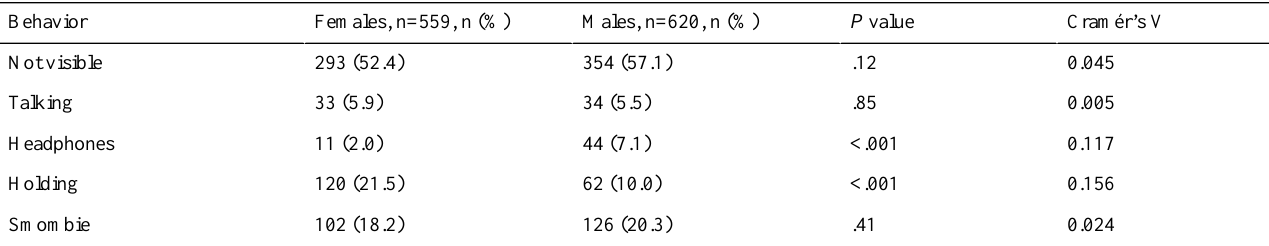
Table 6. Influence of gender on smartphone usage behavior in young people (n=1179, globally P <.001,